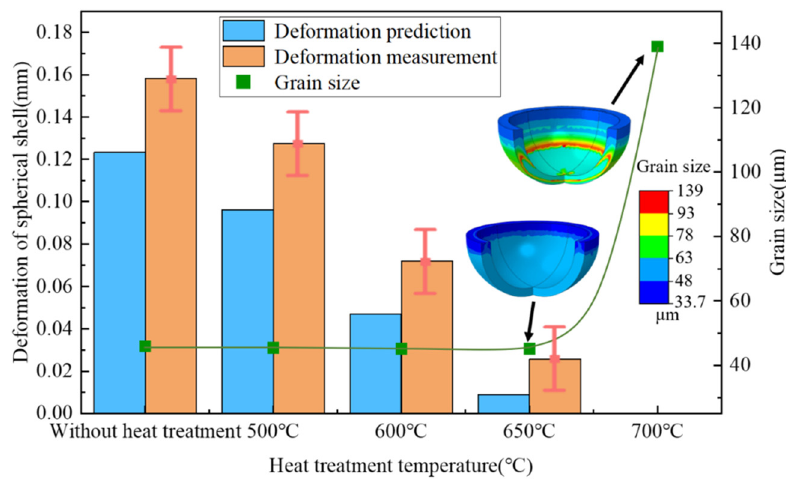
Figure 14: Experimental and simulated results of deformation and grain size for fi nal parts with di ff erent